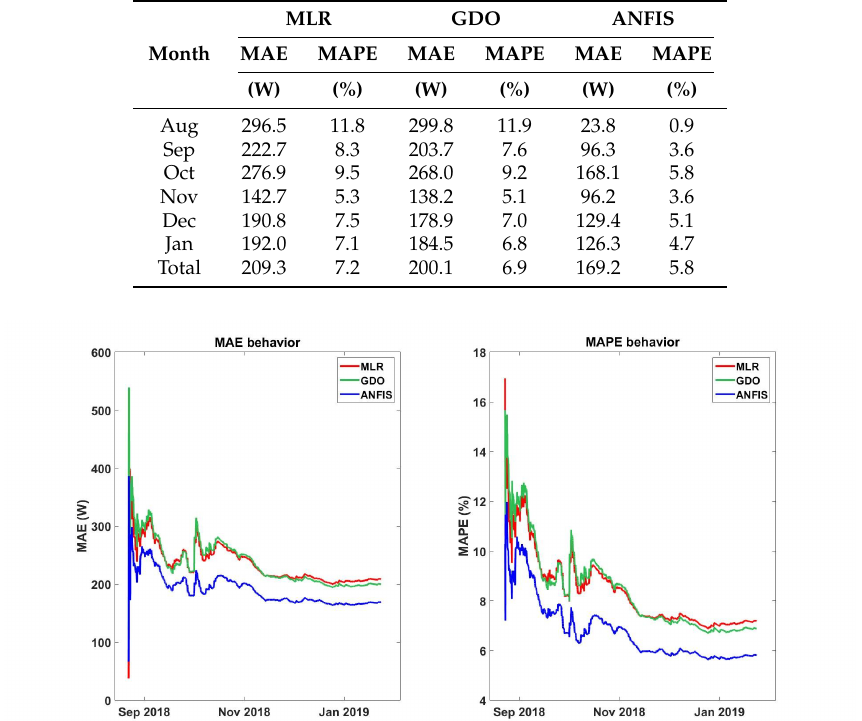
Table 5. Error comparison between MLR, GDO and ANFIS for HS.